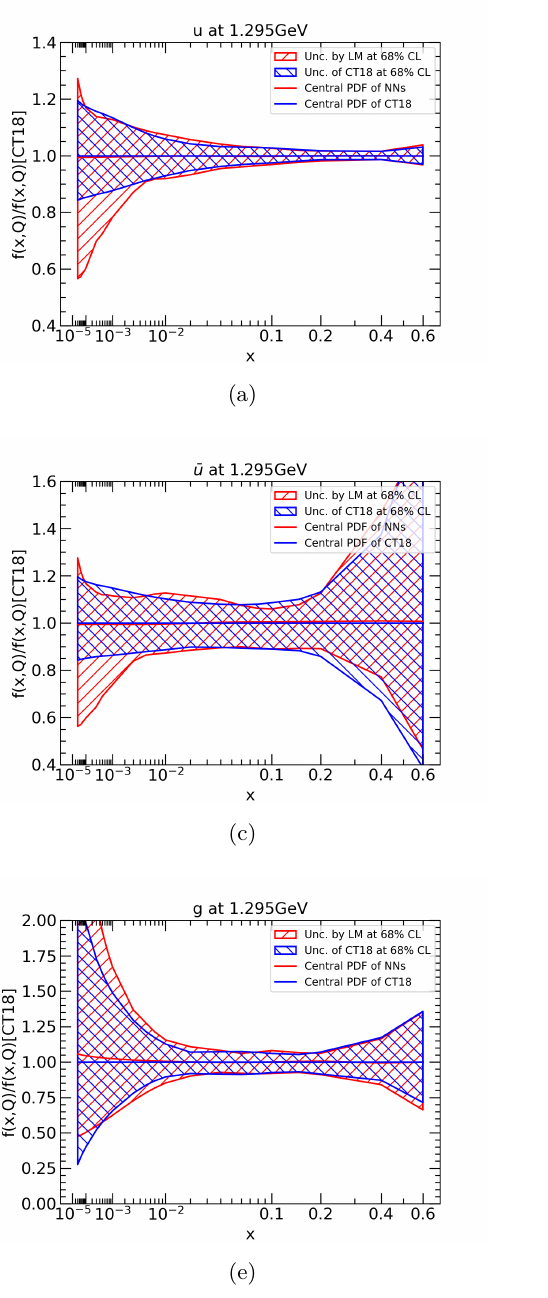
¯ d , g and s . The blue and